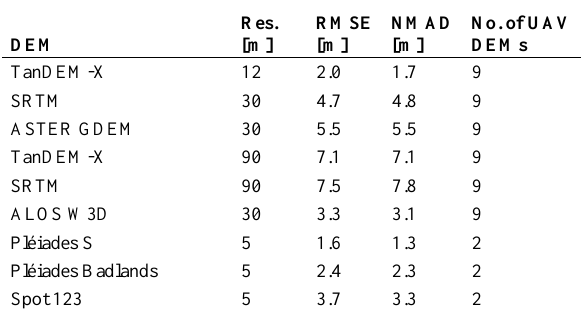
Table 2. Overall accuracies of the digital elevation models compared to very high resolution DEMs derived by UAV. Listed